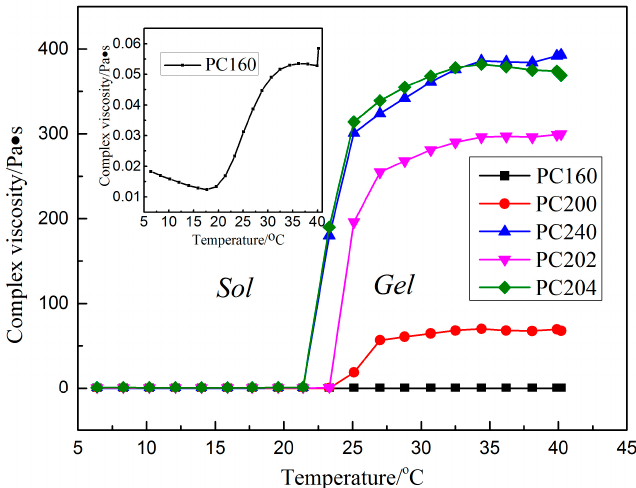
Figure 2. Complex viscosity versus temperature curves of various formulations of P407/carboxymethyl cellulose sodium (CMCs) hydrogel matrix (the data for PC200, PC202 and PC204 were extracted from references [28,29] for the sake of argument).